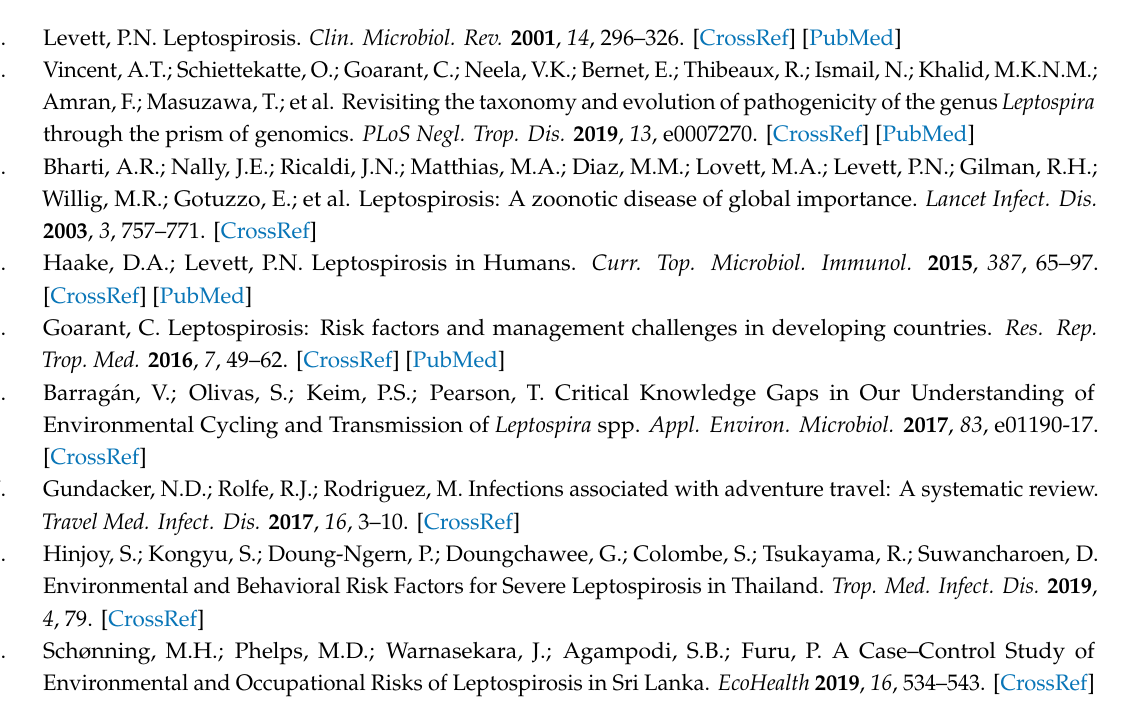
Table S1: 16S rRNA and secY PCR results of the environmental isolates of Leptospira from the elephant camp setting, Table S2: BLASTn analysis results of 16S rRNA and secY gene sequences amplified from each environmental isolate. Author Contributions: Conceptualization, S.C. and M.T.; methodology, S.C., W.P., S.S. and M.T.;